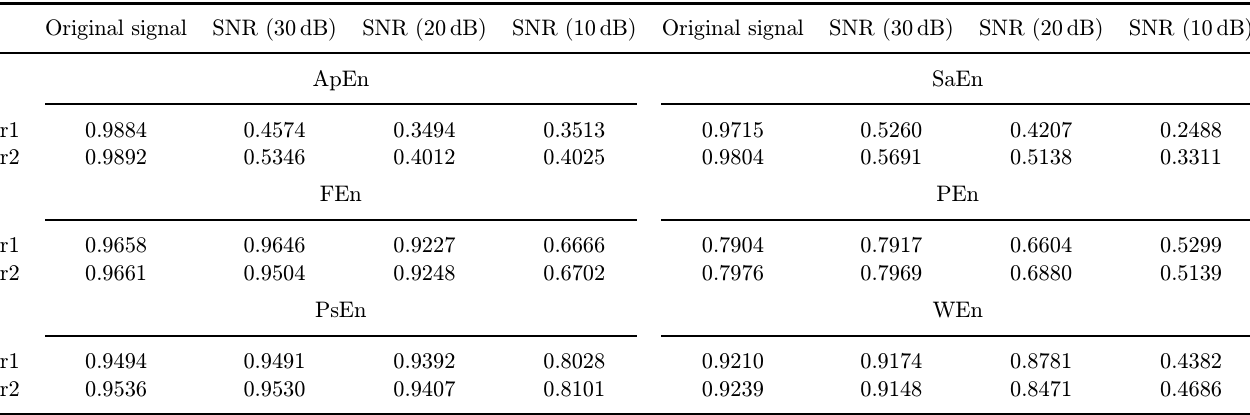
Note : All entropies were signi¯cantly positive correlated to the positive maximal Lyapunov exponent ( p < 0 : 001). The coe±cient r 1 indicates correlation between each entropy and the maximal Lyapunov exponent, and the coe±cient r 2 indicates correlation between each entropy based on EMD and the maximal